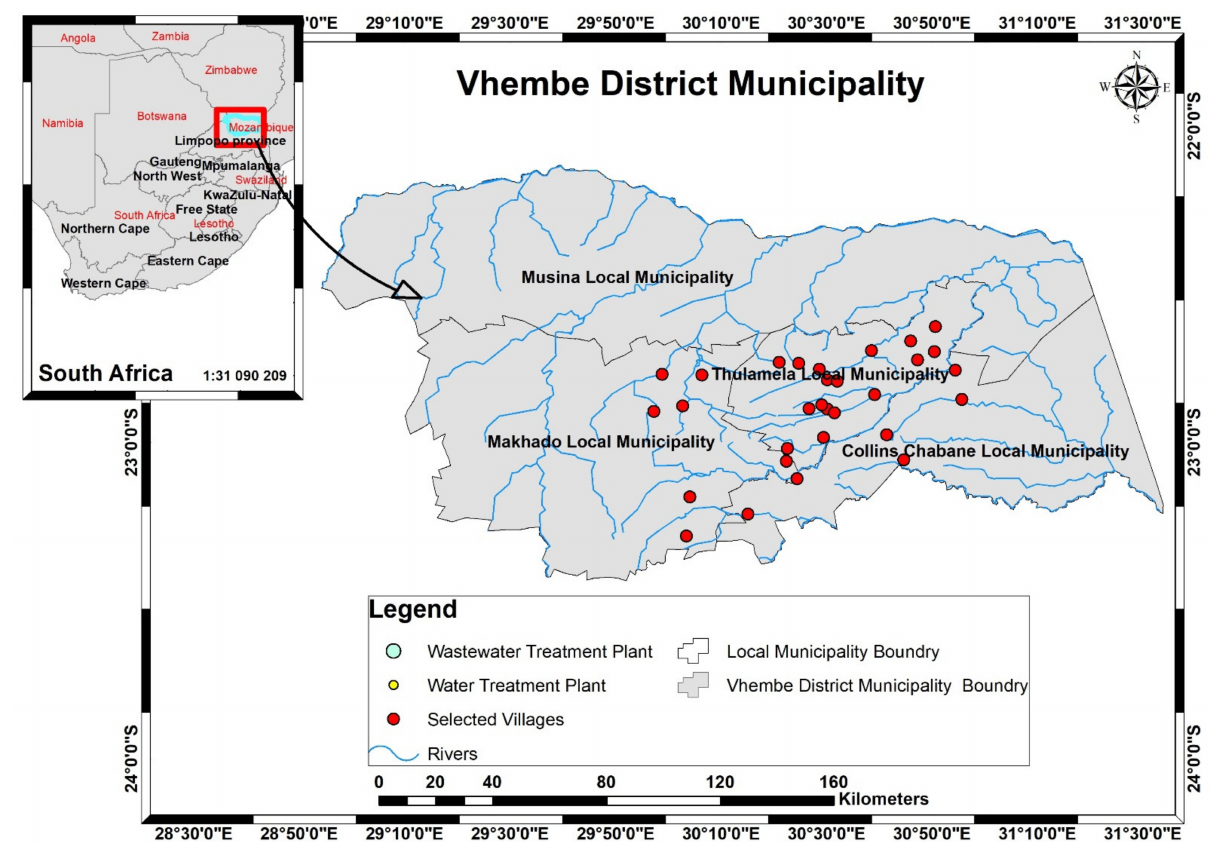
Figure 1. A map showing all four LMs of VDM and the selected areas where the study was conducted. Red circles on the map are the representation of the selected study areas from three municipalities.